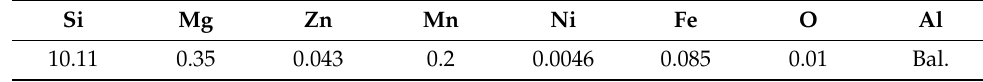
Table 1. Composition of AlSi10Mg powder